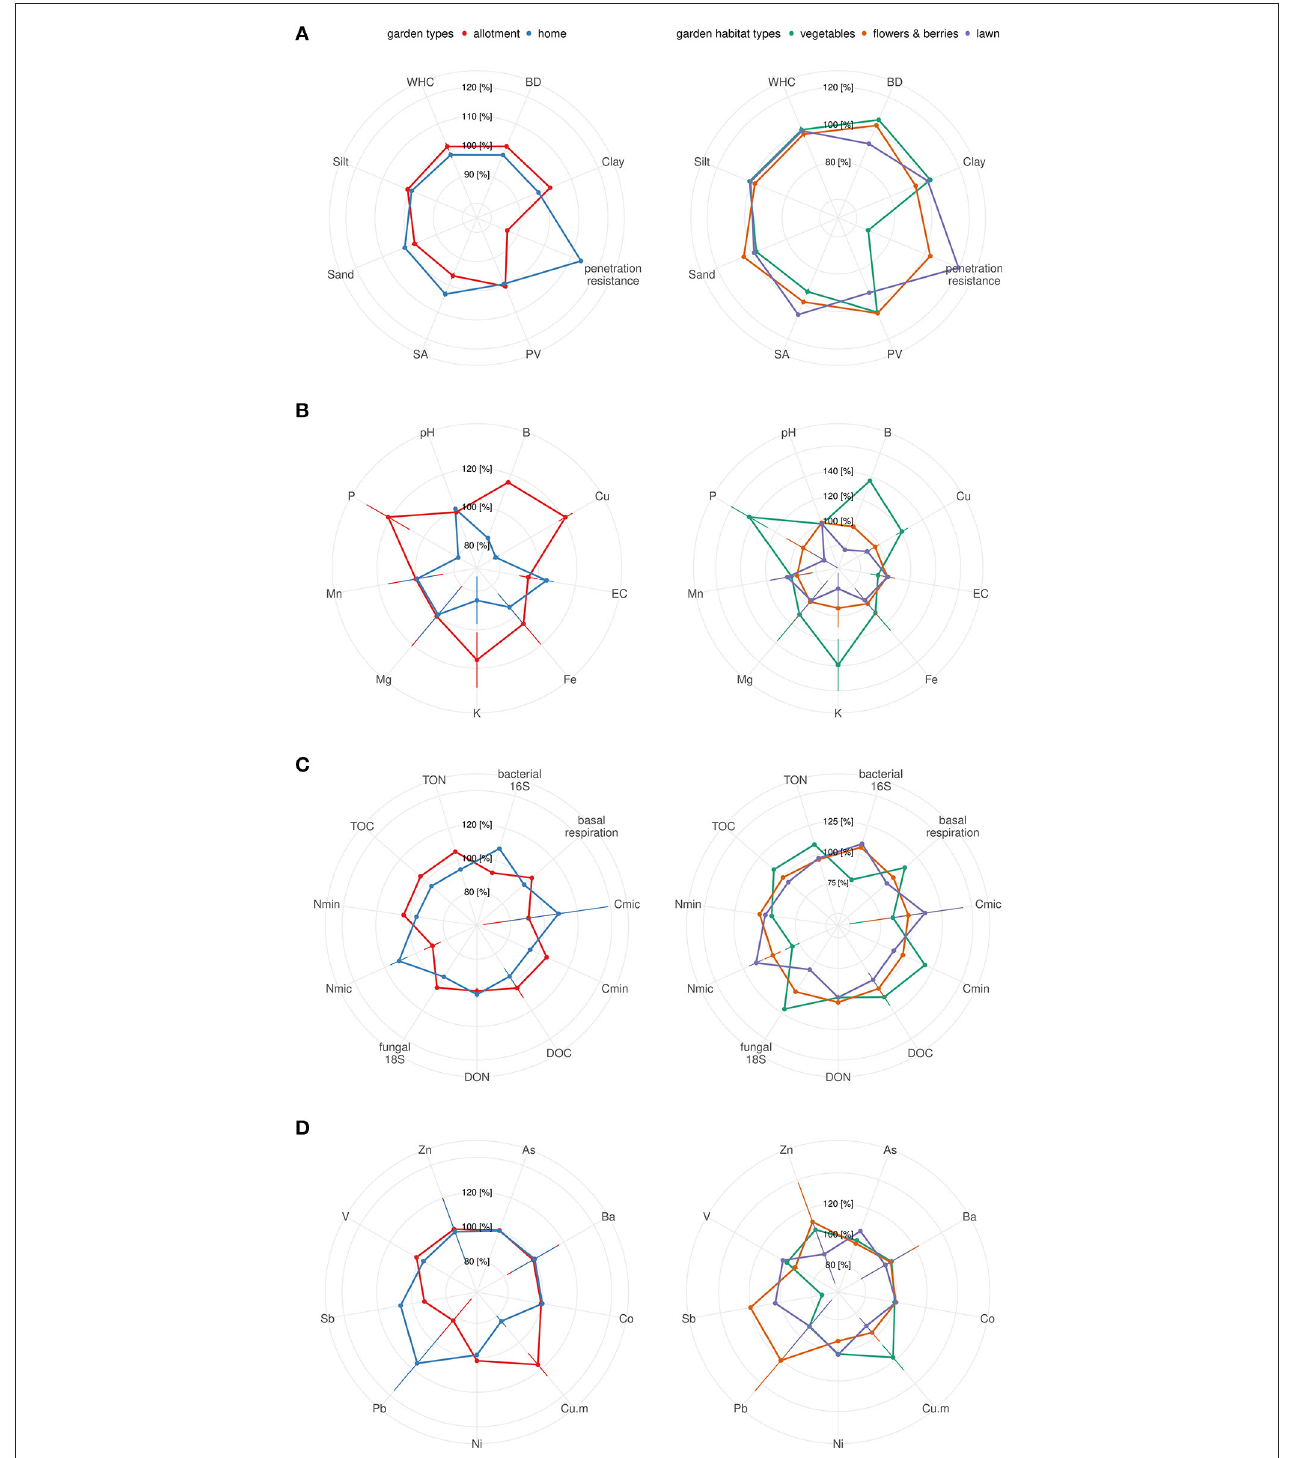
FIGURE 2 | Soil quality indicators per garden type (left) and habitat type (right) consisting of (A) eight physical indicators, (B) nine chemical indicators, (C) eleven biological indicators, (D) nine metal measurements. Data points represent the relative deviation [%] from the grand mean ( Table S4 ) that is set to 100%. Standard error bars are shown with